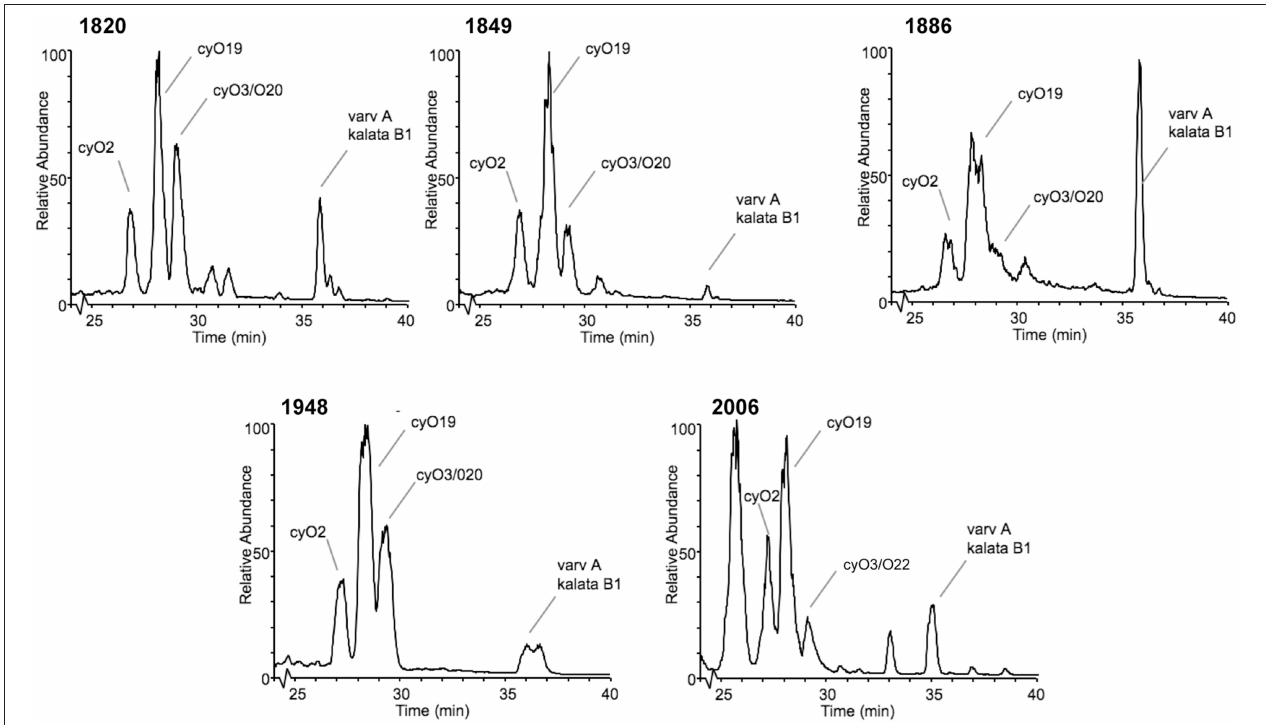
FIGURE 6 | Stability of cyclotides shown in an almost 200-year old sample. Base peak chromatogram (m/z = 800–1900) from five specimens of Viola odorata collected in the years 1820, 1849, 1886, 1948, and a commercially available Viola odorata (2006). The cyclotide region from 25 to 40min is shown, and the major components are labeled. Note that the major cyclotide components—the cycloviolacins O2, O19, and varv A—are present in all